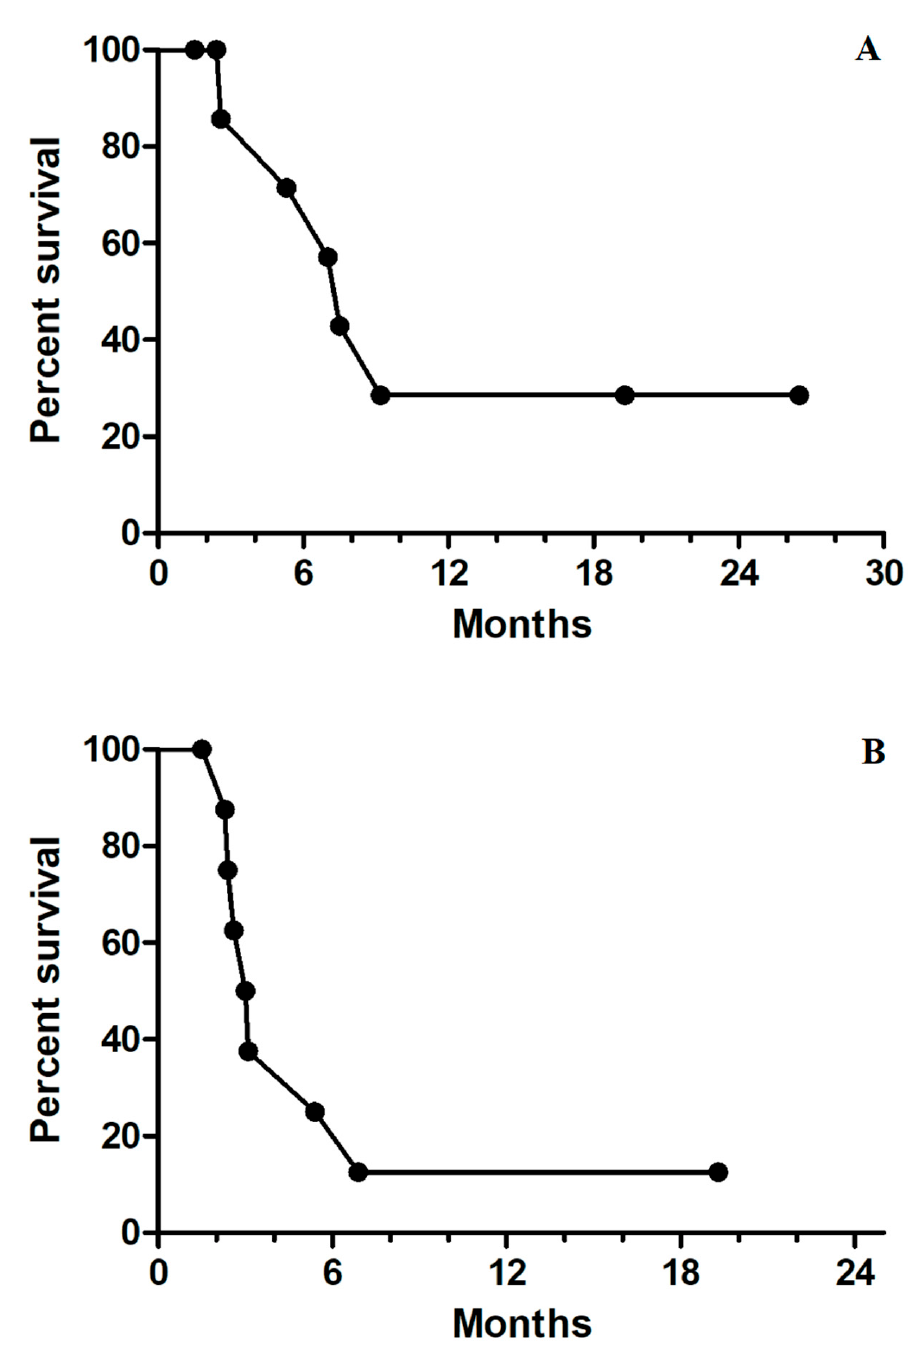
Figure 1. ( A ) Kaplan–Meier survival curves for median progression-free survival of 2.9 months for all nine patients; ( B ) Kaplan–Meier survival curves for median overall survival of 7.4 months for all nine patients.